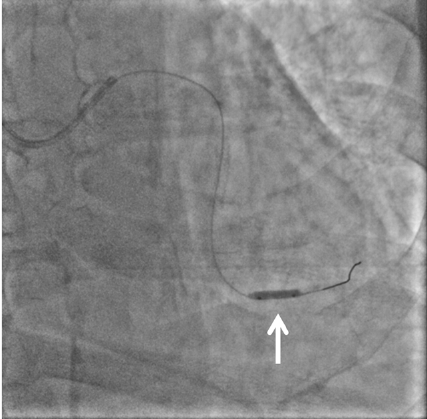
Figure 5: A novel scoring balloon (arrow: NSE Alpha 2.5 × 13mm, Goodman, Japan) was dilated in the far distal